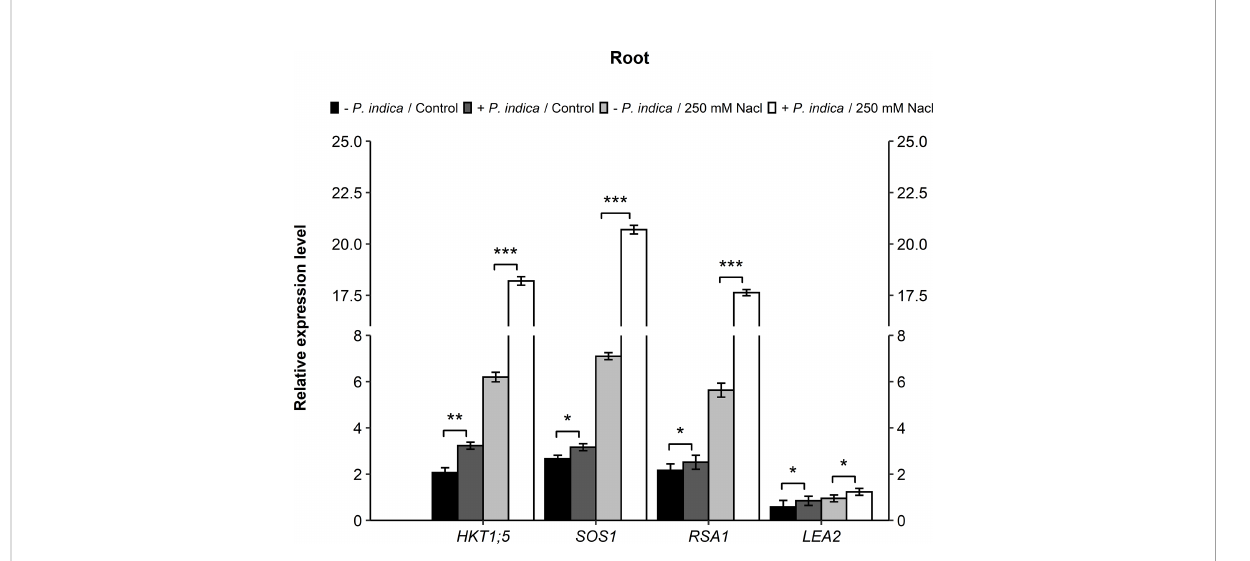
FIGURE 7 Gene expressions ( HKT1;5 , SOS1 , RSA1 , and LEA2 ) in roots of P. indica colonized and non-colonized date palm seedlings grown under control and salt stress conditions. The values are the means ± SD (n = 3), analyzed by Student ’ s t- test, *p < 0.05, **p < 0.01 and ***p <